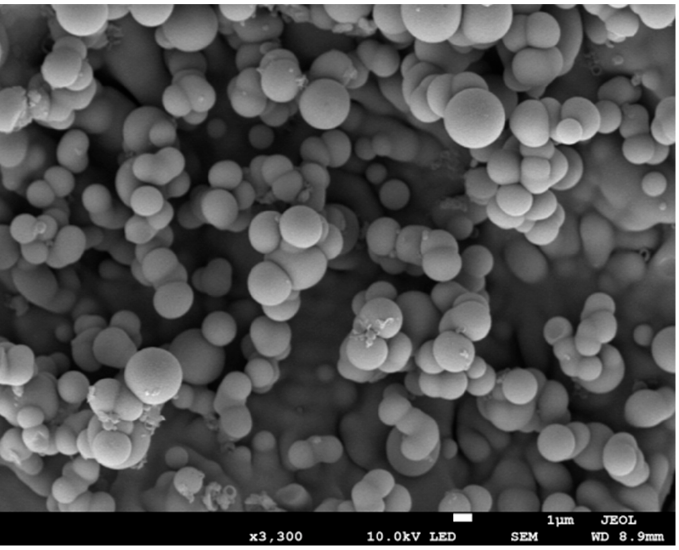
Figure 2. SEM micrograph of a macroscale perspective.